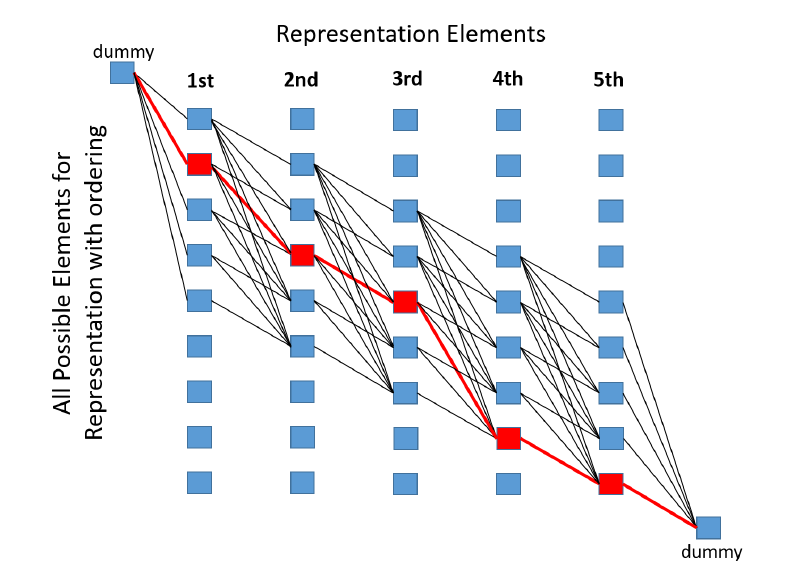
Figure 4. Simplest case of dynamic programming table ( M = 9, B = 5). Nodes are rectangles at a given position in the representation of the threshold marker. Without ordering, two consecutive columns should be fully connected (except same row). Edges represent cost of a given succession in the pattern (goodness of relative fit). Red line is the minimum cost route between the two external dummy node, and it gives the optimal